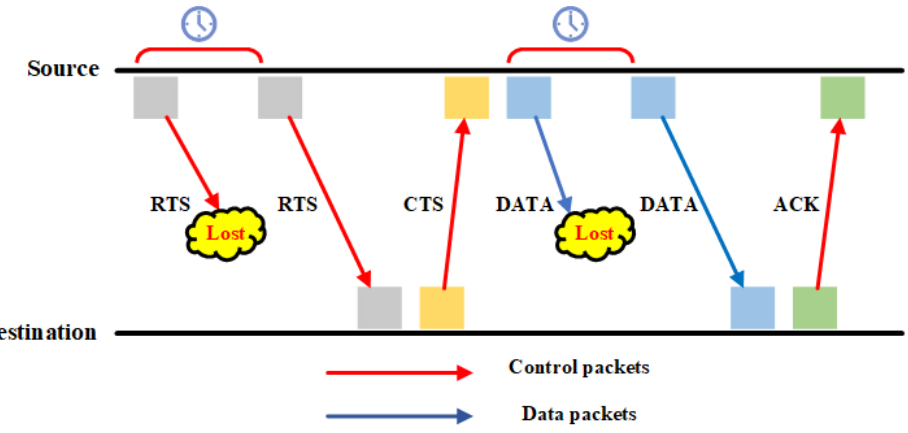
Figure 3. Retransmit Lost Control and Data